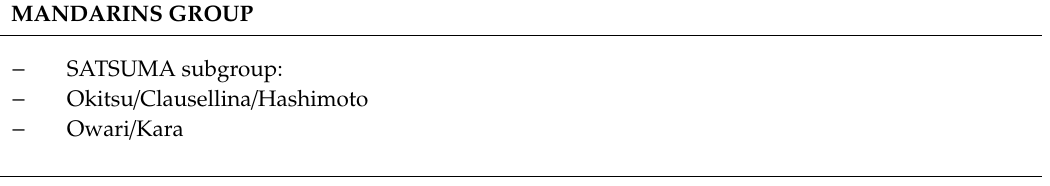
Table A1. Variety grouping